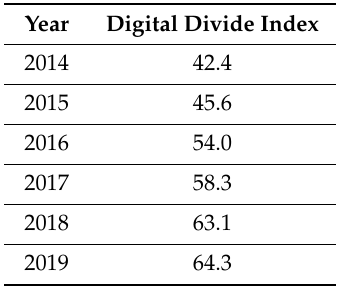
Table 1. Digital Divide Index of older people by year.